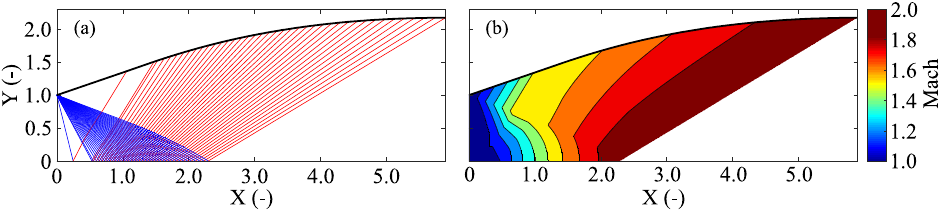
Figure 1. Convergent-divergent nozzle design: ( a ) Characteristic net-blue line: right-running waves, red lines: left-running waves; ( b ) Mach number contour of nozzle divergent region from method of characteristics.